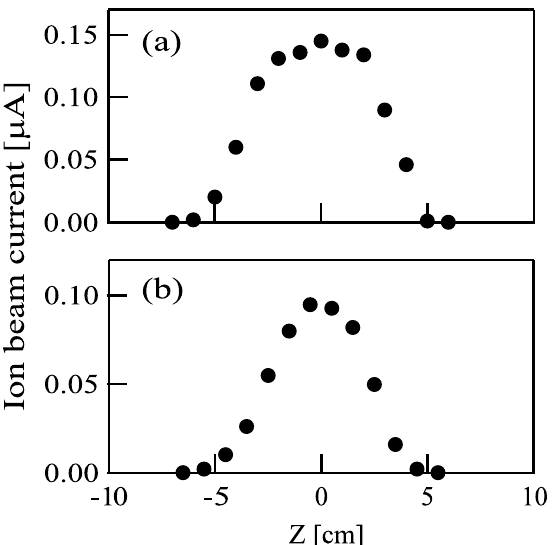
Fig 4. Typical intensity profiles for (a) Ar + and (b) N + ion beams. The ion energies of Ar + and N + ion beams were set at 100 eV. Horizontal axis represents the distance in the vertical